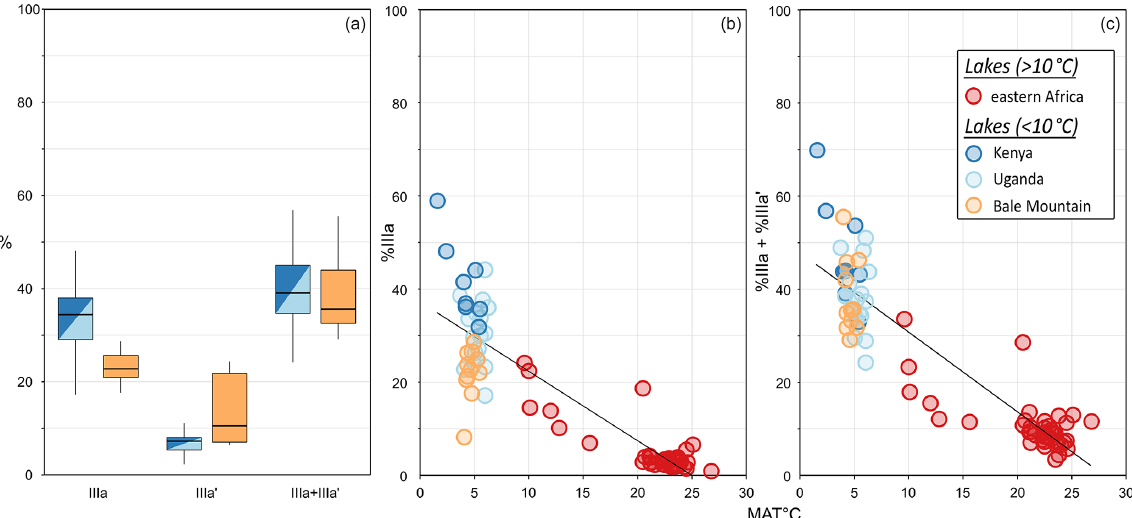
Figure 3. (a) Abundance (%) of IIIa and IIIa (cid:48) ; linear correlation between (b) IIIa (%) and MAT ( r 2 = 0 . 78) and (c) IIIa + IIIa (cid:48) (%) and MAT ( r 2 = 0 . 82) – data from Russell et al. (2018) and Baxter et al. (2019) – lakes > 10 ◦ C (red) and lakes < 10 ◦ C (Bale Mountains – orange, Kenya – blue, and Uganda – light